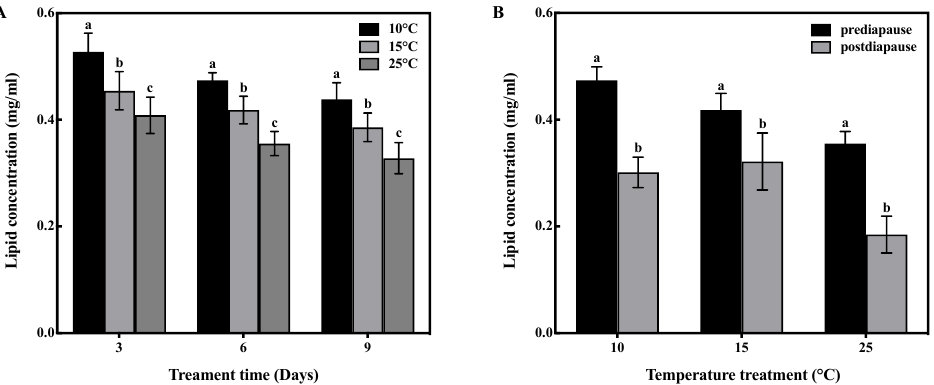
Figure 3. Effect of temperature acclimation on lipid concentration in the fat bodies of queens. The values represent the concentrations (in mg/mL) of tissue samples of medium volume for each sample. ( A ) Effect of temperature acclimation on lipid concentration in the fat bodies of queens during prediapause. Different letters represent statistical significance between the different temperatures ( p < 0.05). ( B ) Effect of temperature acclimation for 6 days during prediapause on lipid consumption in the fat bodies of queens during diapause. Different letters represent statistical significance between the different periods of diapause ( p < 0.05).